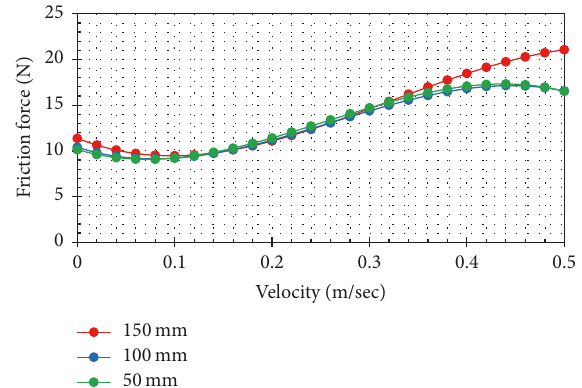
Figure 11: Simulation time history of displacement for the friction functionofmeasuringdisplacementandindividualbestfitandover- all best fitting function (WD40 sprayed with initial displacement of 58.68 mm).